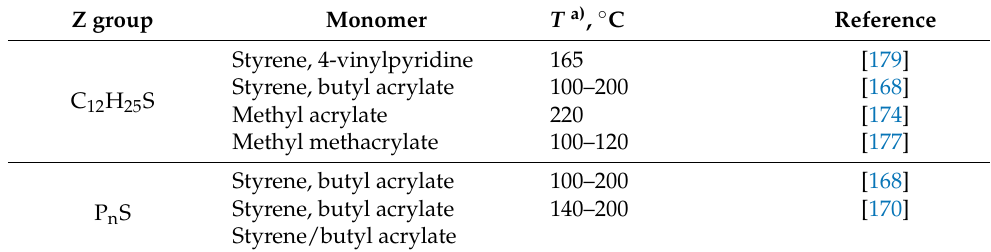
Table 4. Thermolysis data for polymeric